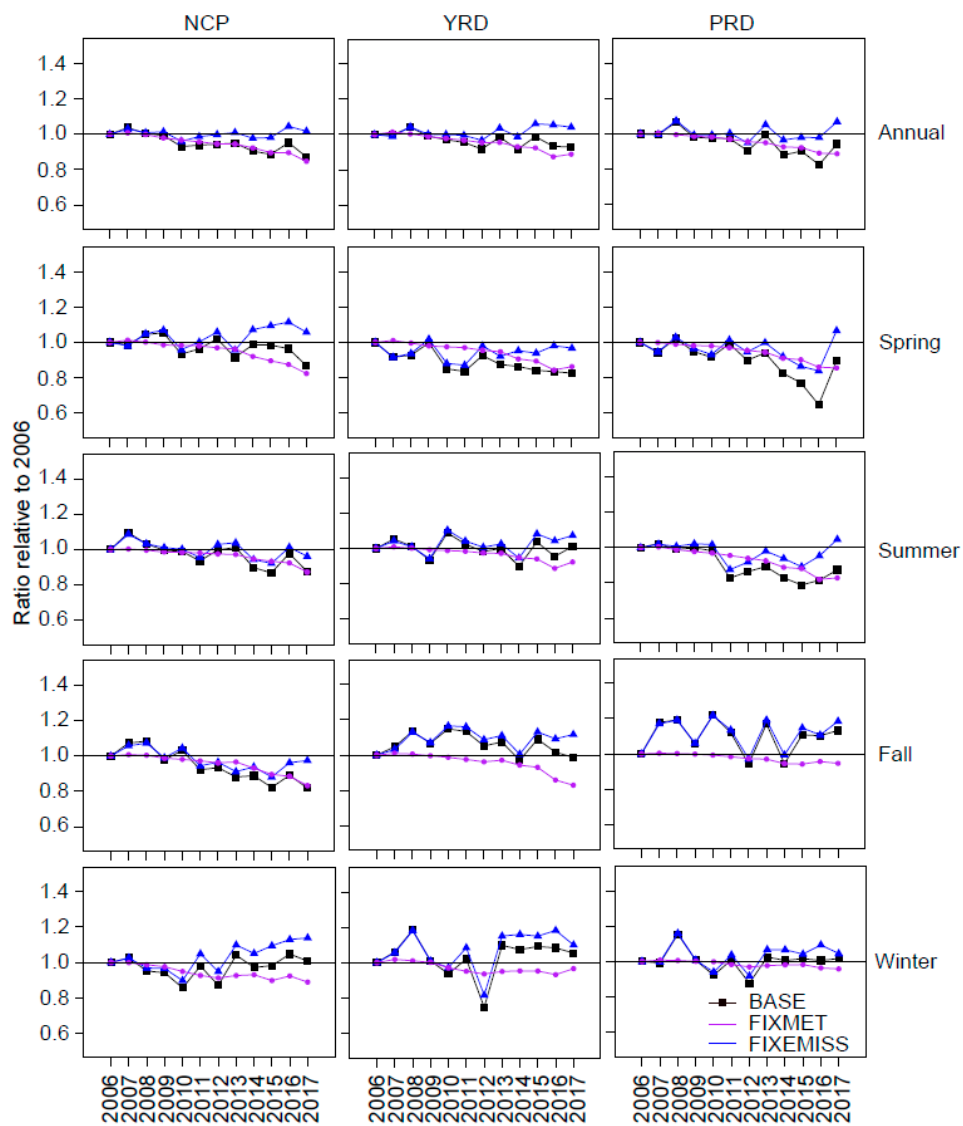
Figure 3. PM 2.5 /AOD ratios ( η ) relative to their values in 2006 in GEOS-Chem simulations in 2006–2017. Three experiments are shown: varying meteorology and varying emissions (BASE, black lines), varying anthropogenic emissions with meteorological fields fixed at the 2009 level (FIXMET, purple lines), varying meteorological fields with fixed anthropogenic emissions at the 2006 level (FIXEMISS, blue lines).